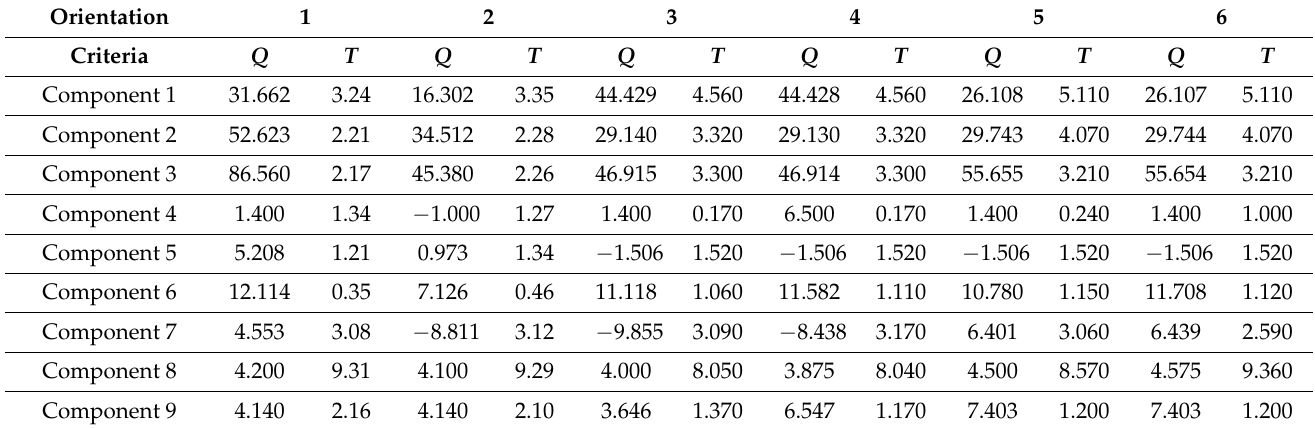
Table 5. Computed values of Q and T for various